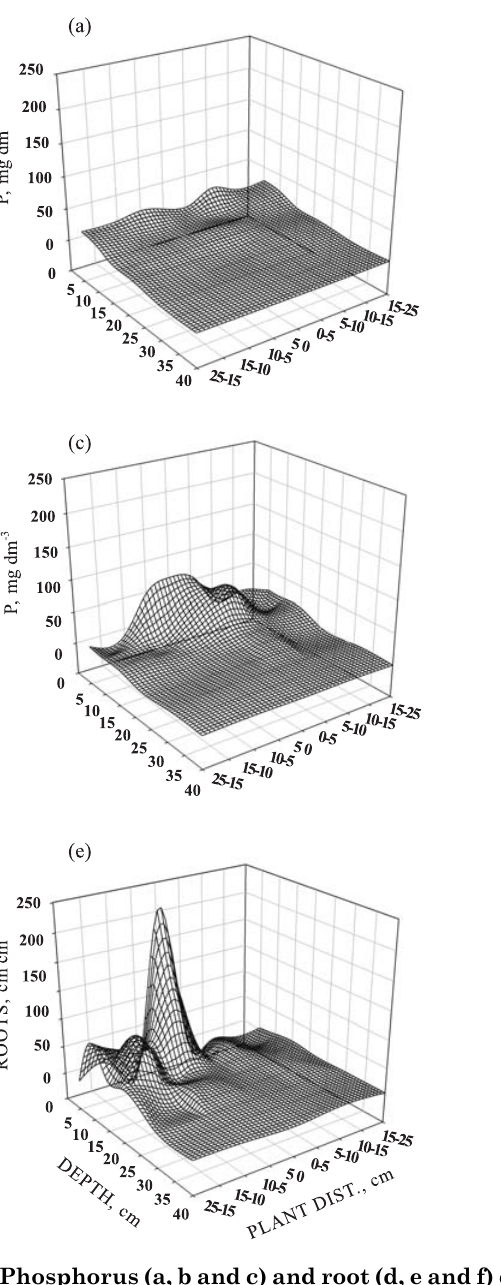
Figure 4. Phosphorus (a, b and c) and root (d, e and f) distribution at corn grain filling period, in a Rhodic Paleudult soil profile under tillage systems: conventional-broadcast, conventional-row and conventional- strip, respectively, for 18 years, 2006/2007 growing season (Representative monolith of the